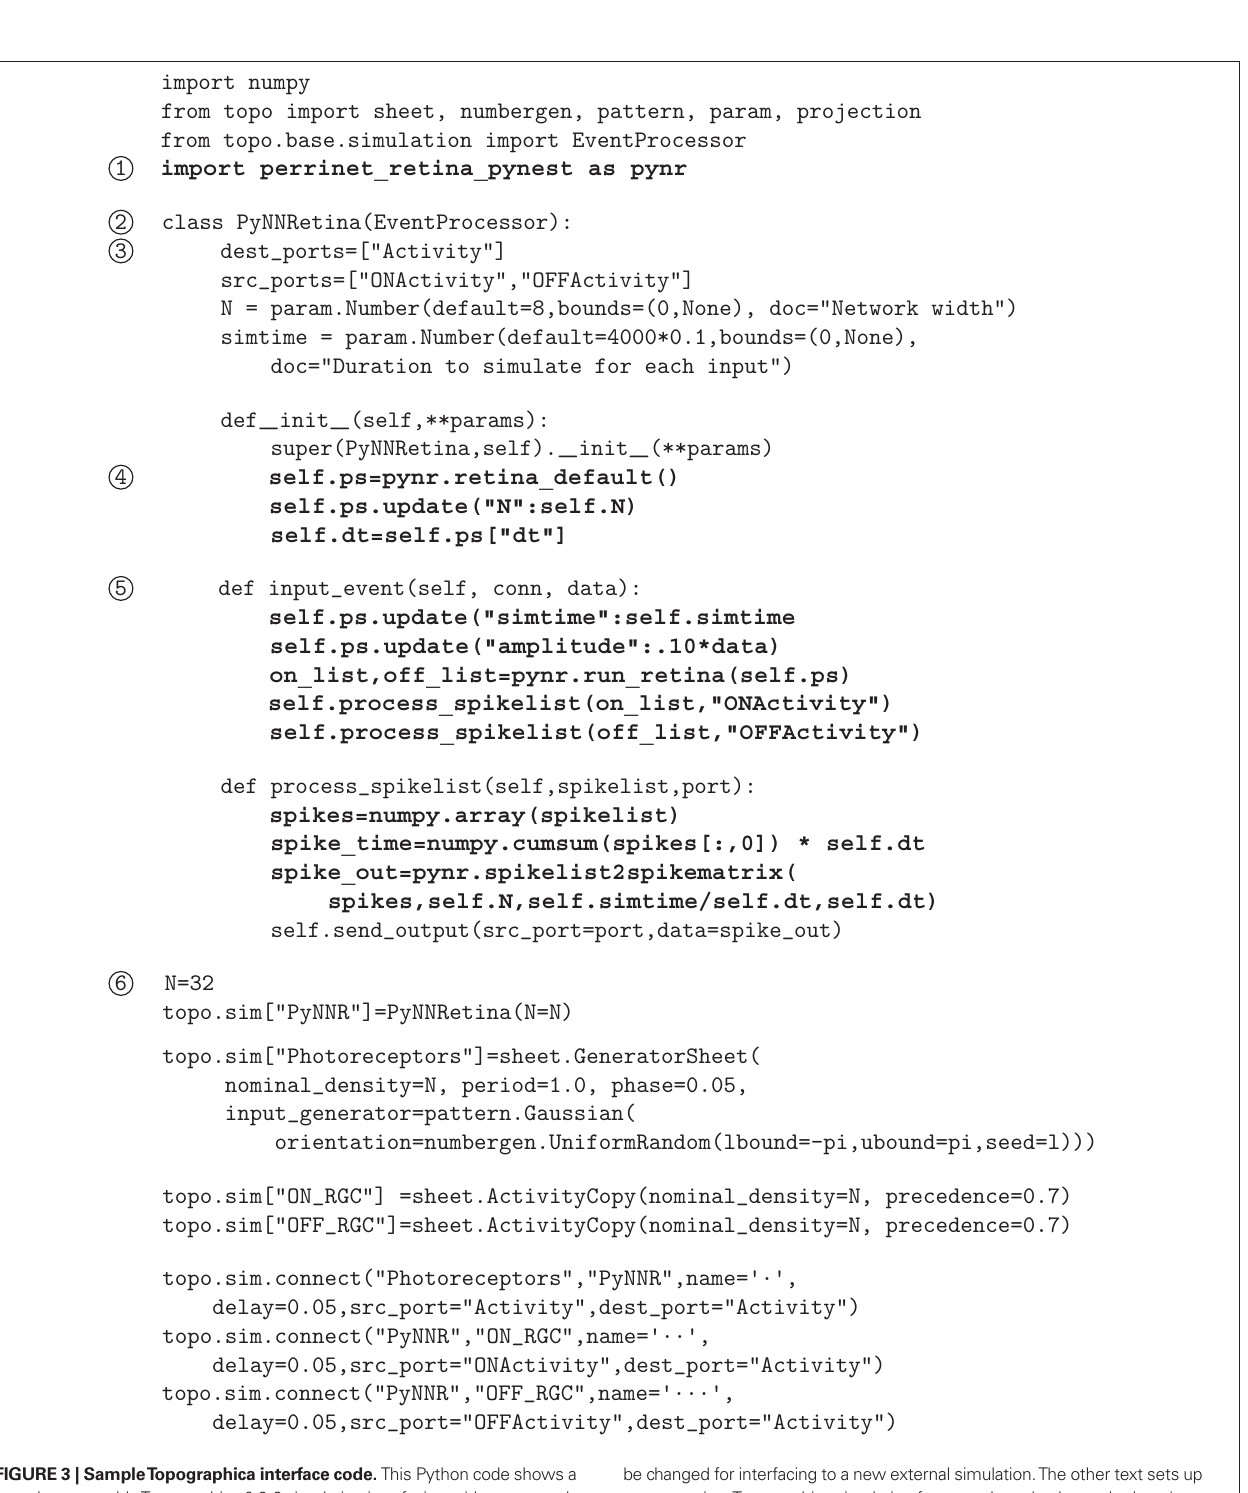
be changed for interfacing to a new external simulation. The other text sets up an appropriate Topographica simulation framework, and only needs changing to e.g. match the number and type of sheets that you want to expose from the underlying external